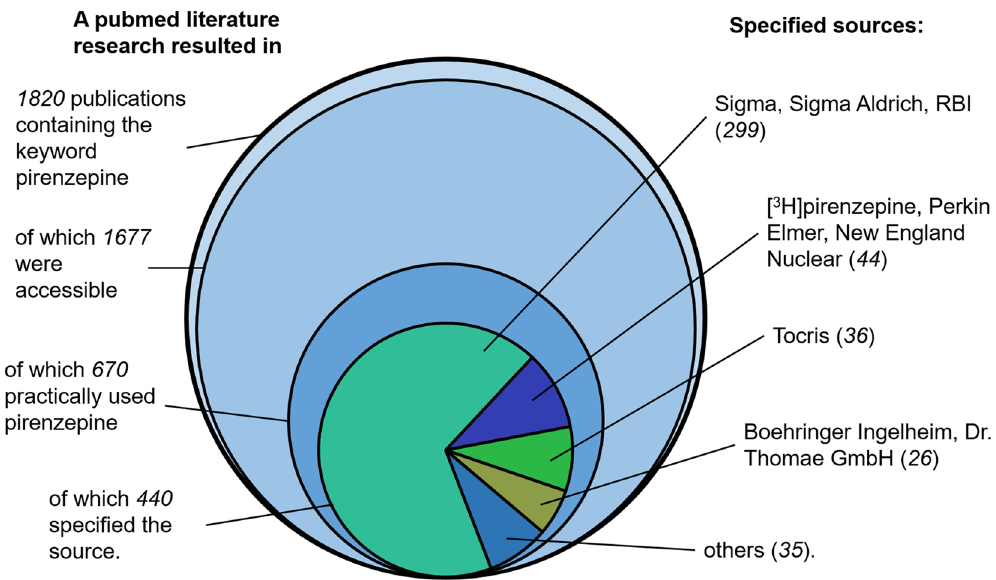
Figure 7. Graphical illustration of the investigated scientific literature about pirenzepine between January 2000 and February 2021 showing the literature research workflow (left) and the specified sources